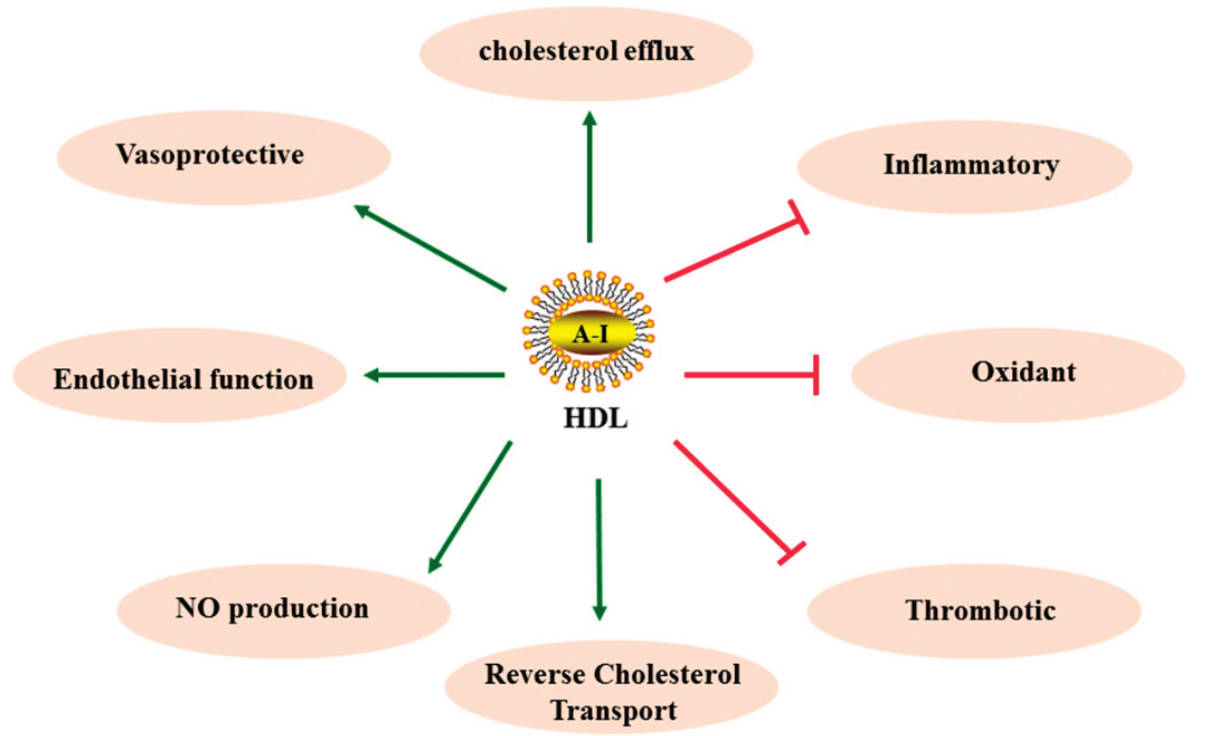
Figure 1. HDL antiatherosclerotic functions. (promotion),